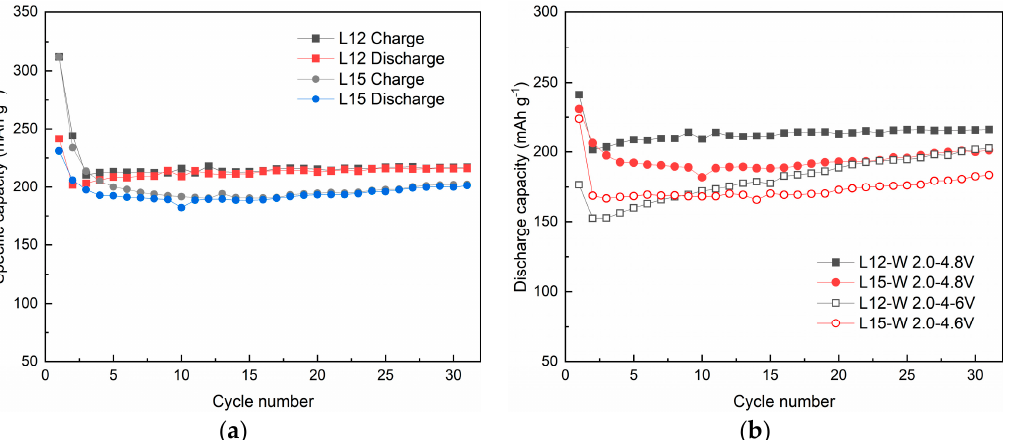
Figure 8. ( a ) Charge–discharge curves of L12 and L15 for 30 cycles within 2.0–4.8 V; ( b ) Cycling performance of L12 and that of L15 were compared in 2.0–4.8 V and 2.0–4.6 V for 30 cycles.